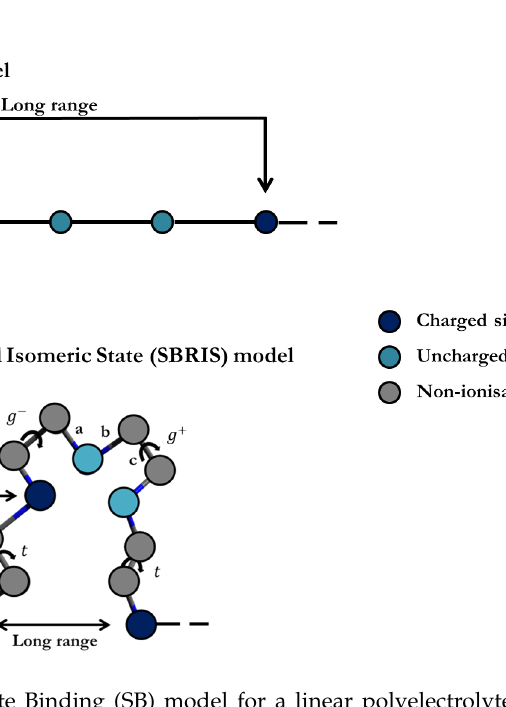
Figure 1. ( a ) Outline of the Site Binding (SB) model for a linear polyelectrolyte represented as a linear chain of ionizable sites. The ionization state of the macromolecule is characterized by a set of variables s = { s i } , i = 1, ... , N , which can adopt two possible values: s i = 1 if the site i is protonated (dark blue circles) and s i = 0 if it is deprotonated (cyan circles); ( b ) sketch of a linear chain joining ionizable sites by means of rotating bonds as an example of the Site Binding-Rotational Isomeric State (SBRIS) model. Both ionization and conformation degrees of freedom are now taken into account. In the depicted chain, only the bonds type c are able to rotate, which can take three possible states of minimum energy, i.e., trans , gauche + and gauche −